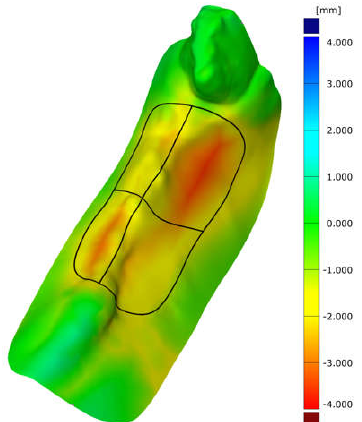
Figure 1. Superimposition of two scans (preoperatively and eight weeks after tooth extraction) shows the dimensional changes over the marked areas (P2/P3 buccal and oral area) in a false-color image. Negative values represent a decrease in area and consecutive reduction in volume. An increase in the volume of the alveolar area is not visible. The black line marks the area of interest and its separation into the buccal and lingual part. The green area surrounding the alveoli illustrates the high congruence in the non-operated areas and proves the exact superposition of the models and the scans,